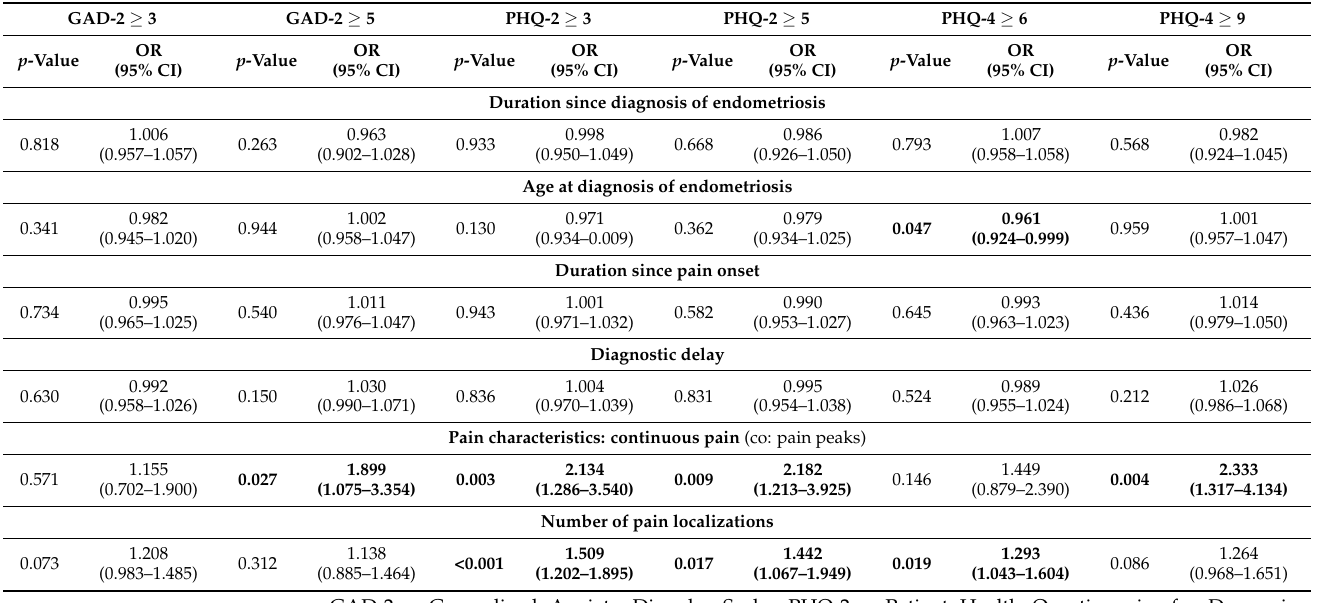
Table 4. Influence of endometriosis-specific variables on self-reported mental health outcomes (univariate logistic regression analysis).